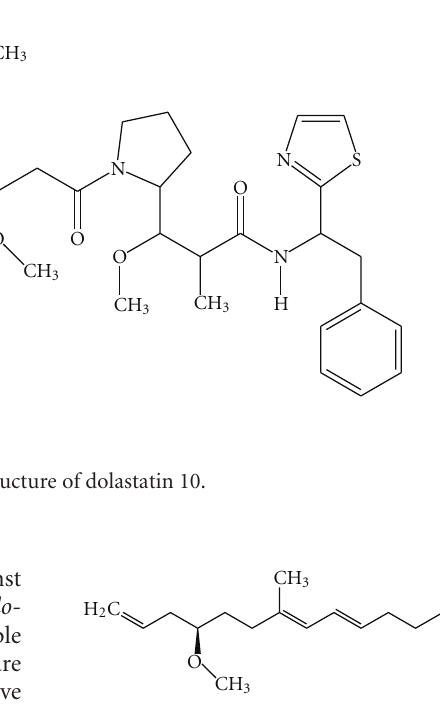
Figure 1: Nomarski di ff erential interference contrasts photomicrographs of sheathed cyanobacterial strains. (a) Chroococcus sp. (1000x); (b) Phormidium sp. (1000x).